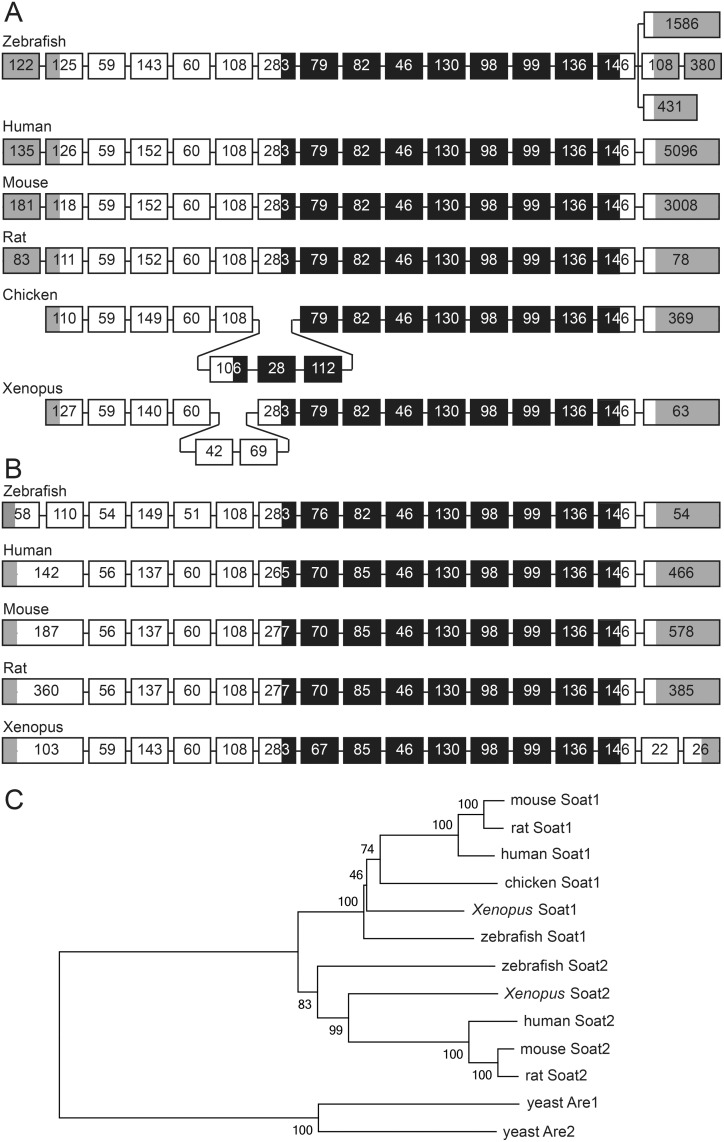
Comparative in silico analysis of soat1 and soat2.(A-B) Genomic organizations of soat1 (A) and soat2 (B) in zebrafish, human, mouse, rat, Xenopus and chicken showed similar pattern of exonal distributions. In the regions coding for MBOAT domains, the exon/intron structures are almost indentical between soat1 and soat2 and among various species. The sizes of the exons are shown in the box representing exons, the grey area in the exon boxes are untranslated regions, and the black regions represent MBOAT domains. (C) Phylogenetic trees were constructed using neighbor joining method with percentage identity distances with the software Jalview2, and showed that soat1 and soat2 genes are grouped together respectively, with yeast ARE1 and ARE2 as outgroups. The reference genes used in this comparative analysis include: SOAT1 of human (ENST00000367619), mouse (ENSMUST00000051396), rat (ENSRNOT00000005677), chicken (ENSGALT00000006691), Xenoupus (ENSXETT00000050224), SOAT2 of human (ENST00000301466), mouse (ENSMUST00000023806), rat (ENSRNOT00000015368), xenopus (ENSXETT00000003832), and yeast are1 (YCR048W), and are2 (YNR019W). The sequences of zebrafish soat1 and soat2 were obtained from the cloned sequences.